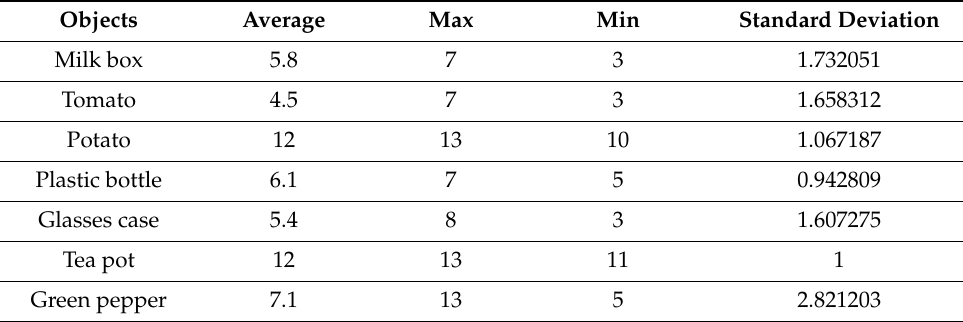
Table 2. Comparison of grasping bending results (degrees).